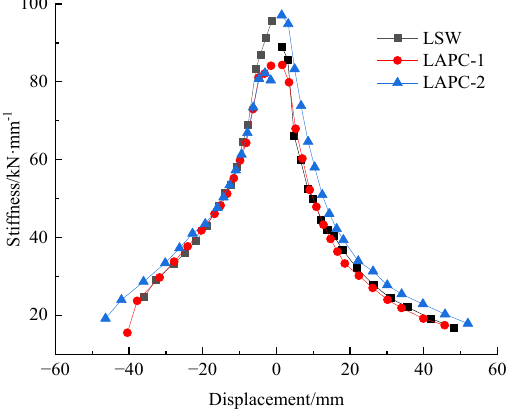
Figure 10. Comparison of stiffness degradation curves of specimens.